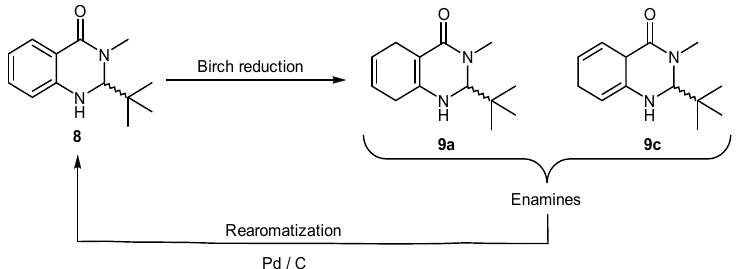
11 of 16 Figure 11 . Structure and X-ray diffraction of hexahidroquinazolinone ( 13 ). We have shown that by exchanging allylic hydrogen in N 1, the photooxidation of compound 13 does not occur under crystallization by diffusion. We suggest that the stability